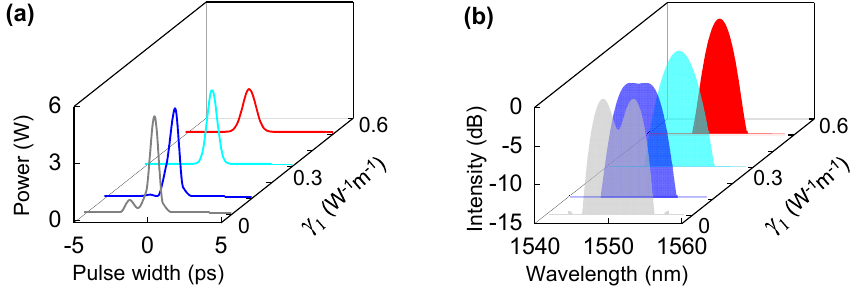
Figure 5. Temporal profile ( a ) and the corresponding spectrum ( b ) with χ ( 3 ) coefficient γ 1 increases from 0 to 0.5 W − 1 m − 1 for the pump pulse width of 16